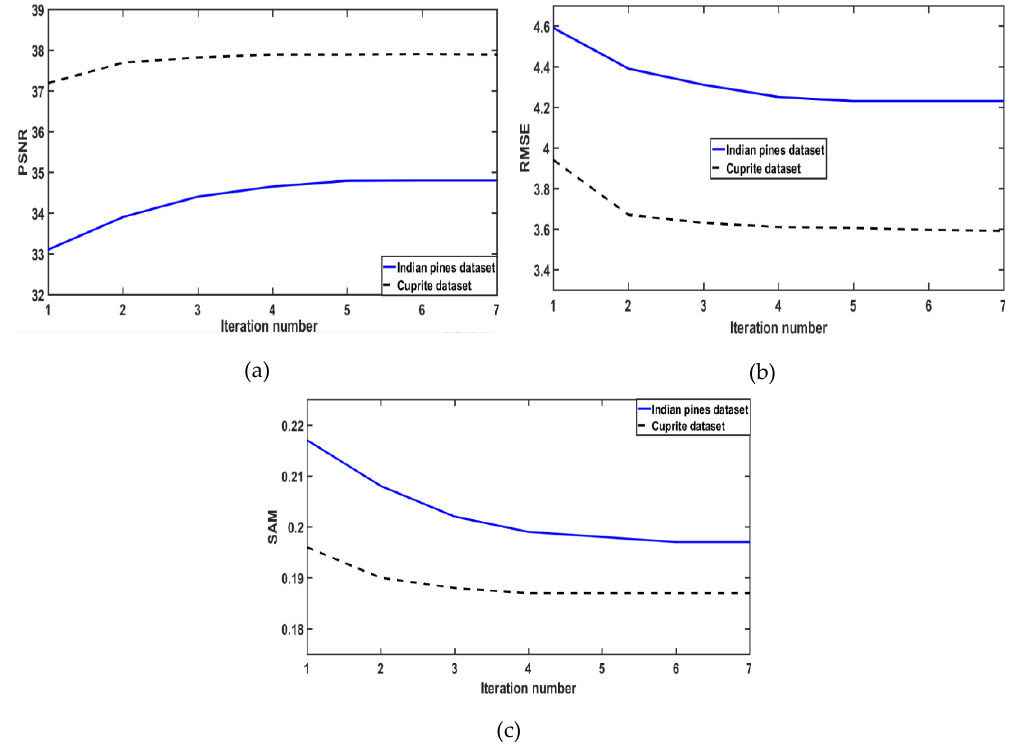
Figure 8. Assessment values of each iteration on both Indian pines dataset and Cuprite dataset ( a ) Peak Signal-to-Noise Ratio (PSNR), ( b ) Root-Mean-Square Error (RMSE), and ( c ) Spectral Angle Mapper (SAM).